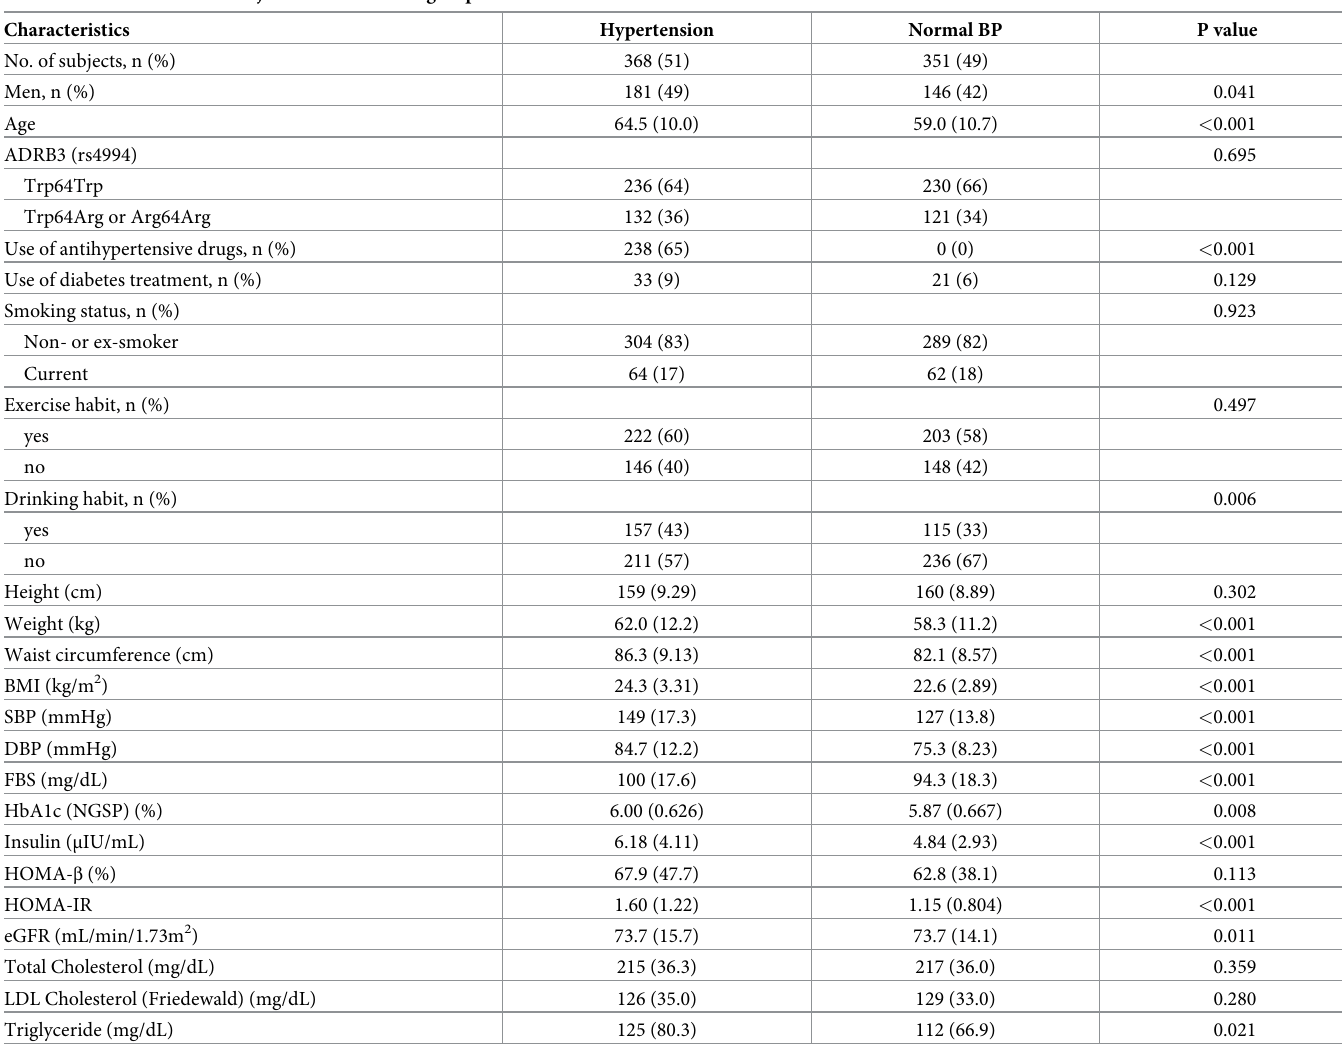
Table 3. Characteristics of subjects in different BP